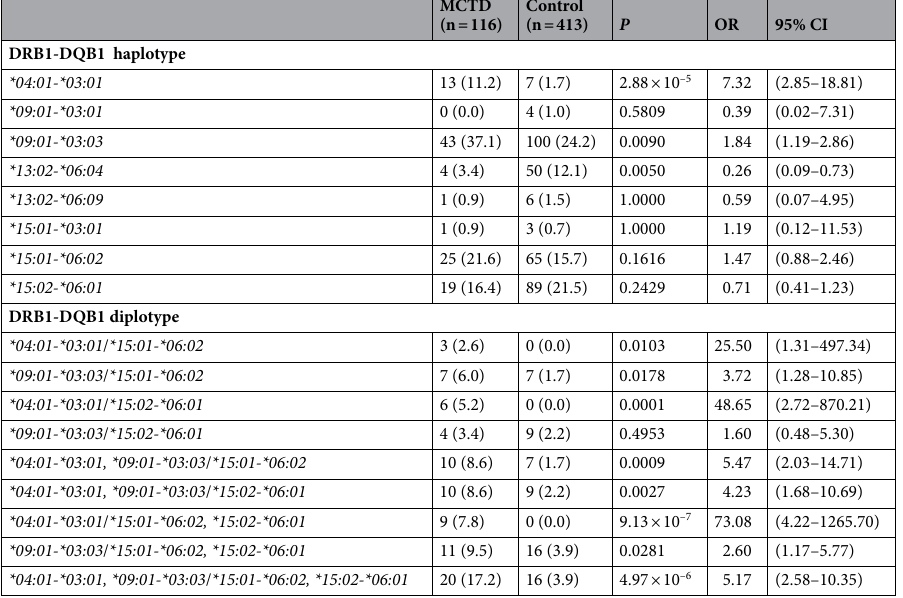
Table 4. HLA-DRB1-DQB1 haplotype carrier or diplotype frequency in MCTD patients and controls. Haplotype carrier or diplotype frequencies are shown in parentheses (%). Association was tested by Fisher’s exact test, using 2 × 2 contingency tables. Haplotype carrier frequency is the frequency of individuals with a specific haplotype in some populations. Diplotype frequency is the frequency of individuals with a specific diplotype in some populations. MCTD: mixed connective tissue disease; OR: odds ratio; CI: confidence interval.